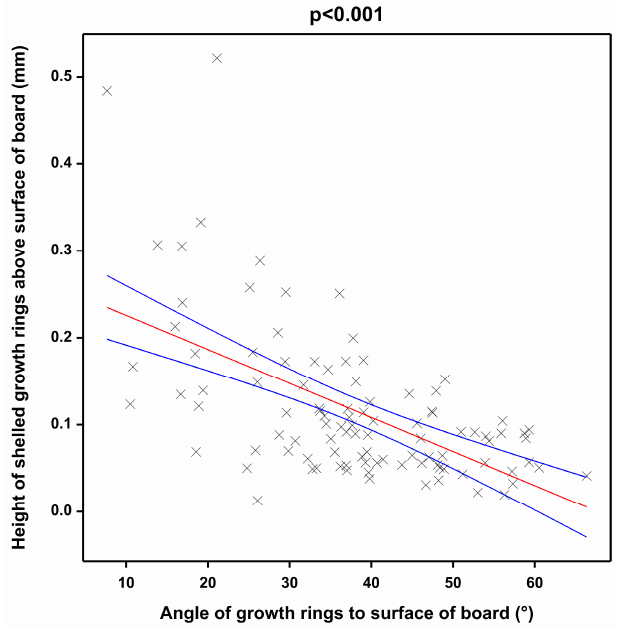
Figure 3. Linear regression (red line) of heights of latewood in shelled growth rings versus growth ring angle in flat western larch deckboards oriented pith-side-up and exposed to the weather for seven months in Vancouver, Canada; regression includes 95% confidence intervals (blue-lines).